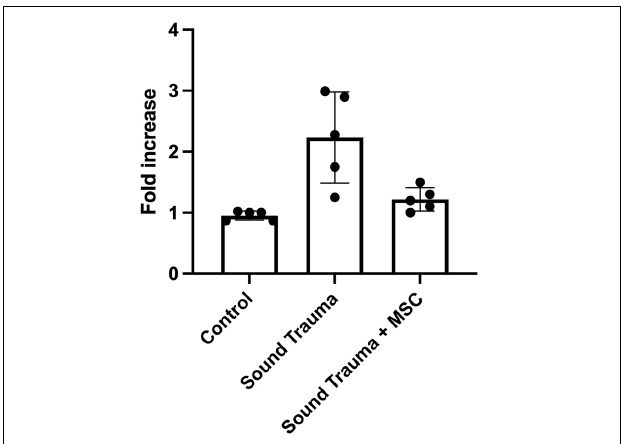
FIGURE 9 | Expression of cochlear transthyretin by semi quantitative RT-PCR. Sound trauma treated animals showed a relative increase in expression of transthyretin mRNA. MSC treatment resulted in a significant reduction in expression of transthyretin mRNA after sound trauma ( p = 0.001).